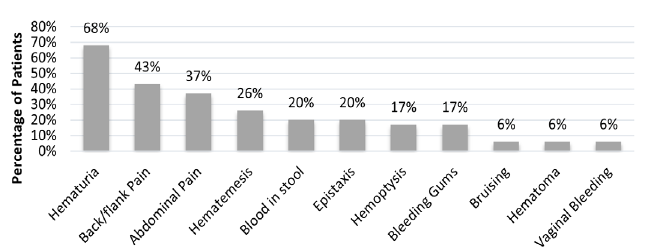
Figure 1. Thirty-eight patients with identified exposure to super warfarin-tainted synthetic cannabinoids.